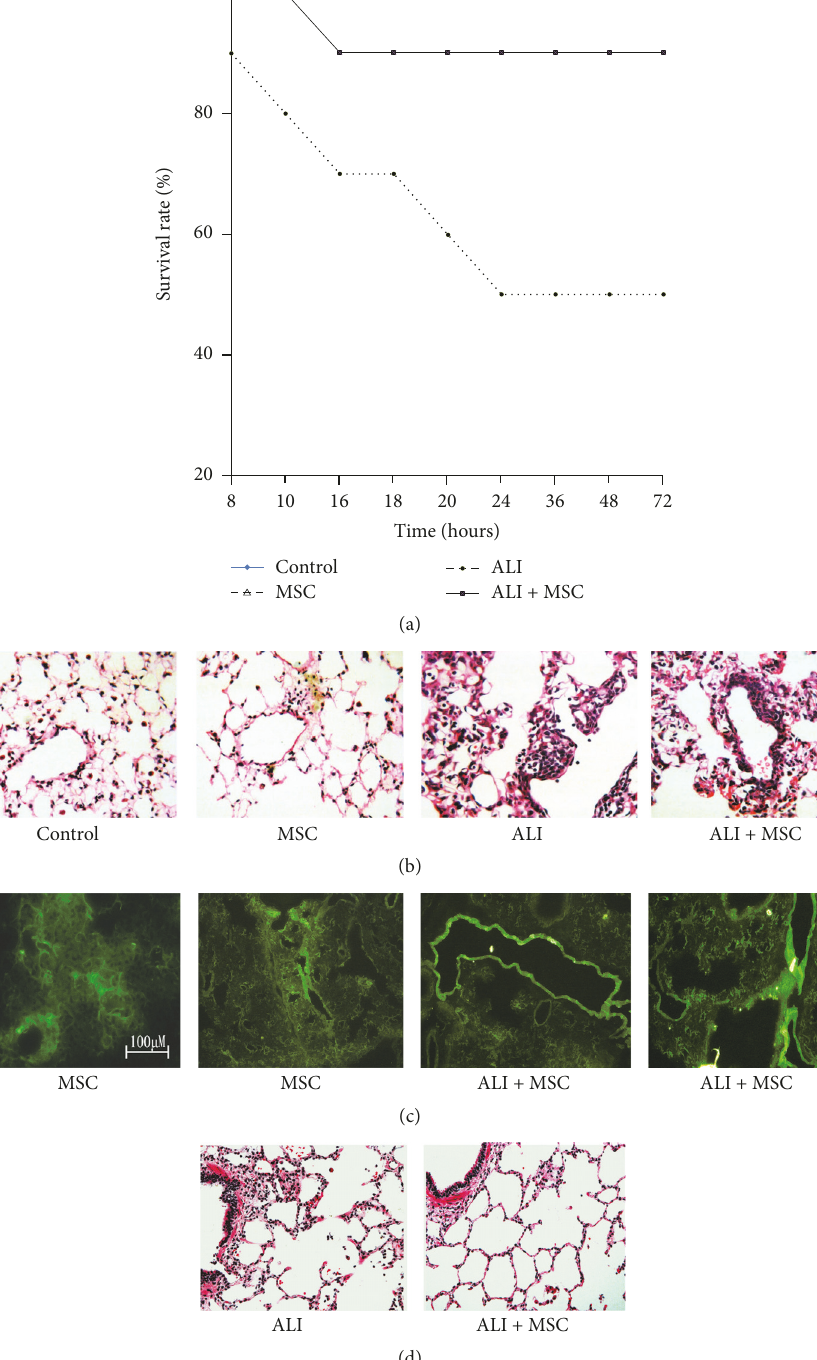
Figure 2: Protective action of MSCs was determined by survival rate and HE staining. (a) The survival assay. The survival rate was nearly 50% at 72 h, and administration of MSCs significantly increased survival rate to 90%. (b) HE staining at 24 hours after MSCs administration. The lung tissues from the LPS group demonstrated significantly pathological alterations, which was attenuated by MSCs administration. (c) Distribution of MSCs at 24 hours after MSCs administration. Fluorescence was distributed throughout the distal lungs when administrating MSCs into normal rats; however, the fluorescence was mainly distributed in larger blood vessels when administrating MSCs into ALI Rats. (d) HE staining at 7 days after MSCs administration. Lung injury was obviously attenuated by MSCs